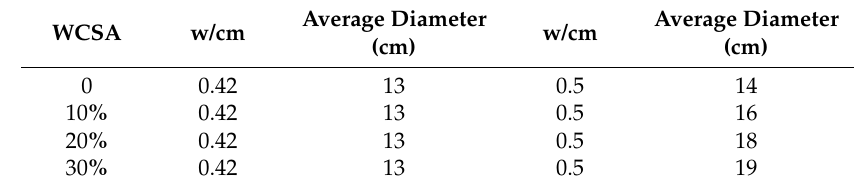
Table 4. Workability of mixture.